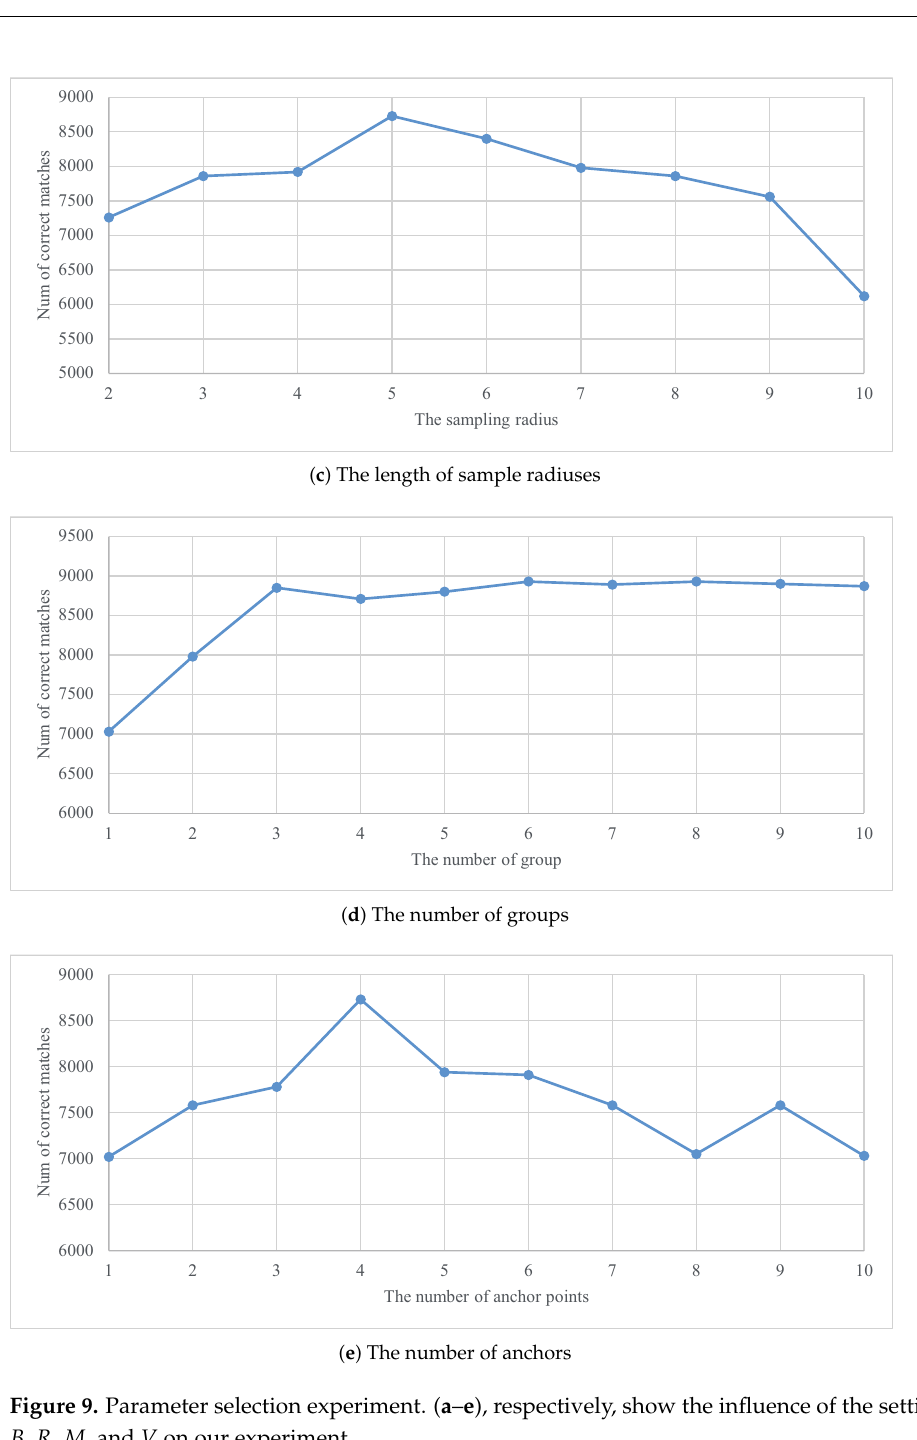
Figure 9. Parameter selection experiment. ( a – e ), respectively, show the influence of the setting of h , B , R , M , and V on our